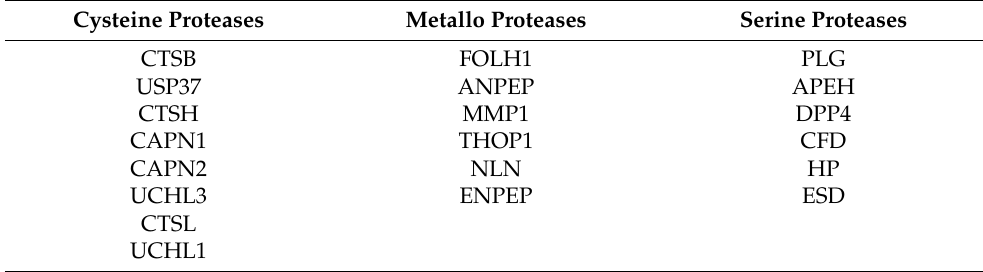
Table 1. Identified proteases in both sample groups using Panther pathway analysis.